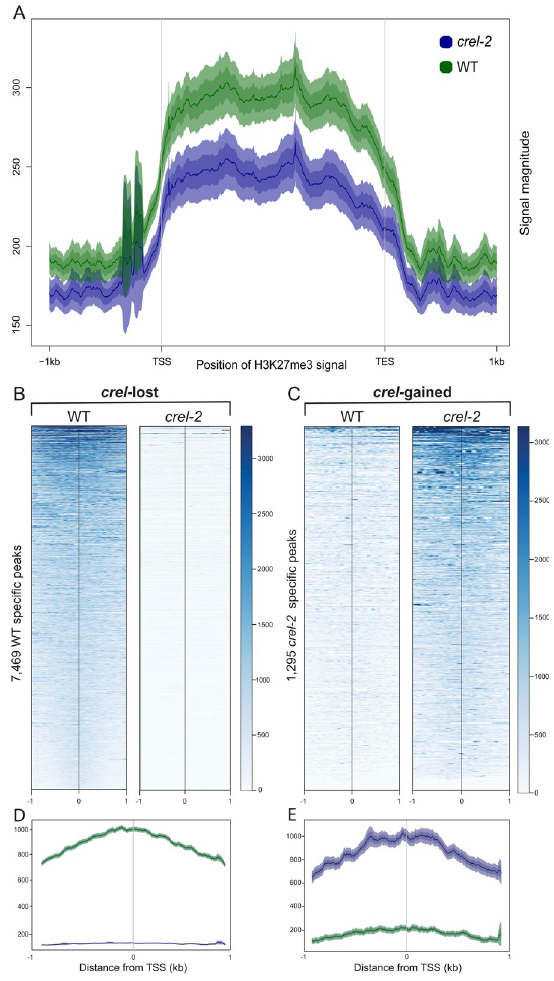
Fig 7. CREL mediates H3K27me3 modifications at a subset of polycomb-target sites. (A) Normalized H3K27me3 signal displayed across all protein-coding genes in WT and crel-2 mutant shoot apices. (B) Heatmaps of H3K27me3 signals at 7,469 sites identified as reproducibly enriched in WT but lost in crel-2 ( crel -lost sites). Signals are centered in the middle of each enriched region and extend +/- 1 kb in each direction. (C) Heatmaps of H3K27me3 signals at 1,295 sites identified as reprodicbly enriched in crel-2 plants but not in WT ( crel -gained sites), displayed as in (B). (D) Average plots of WT and crel-2 H3K27me3 at the 7,469 crel -lost sites shown in panel B. (E) Average plots of WT and crel-2 H3K27me3 at the 1,295 crel -gained sites shown in panel